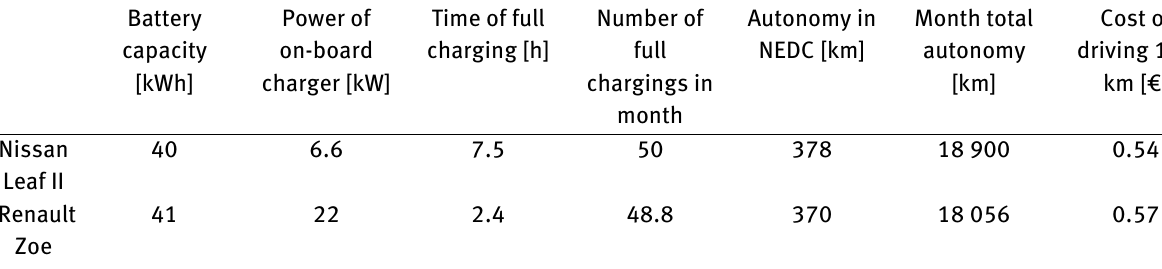
Autonomy in NEDC [km]